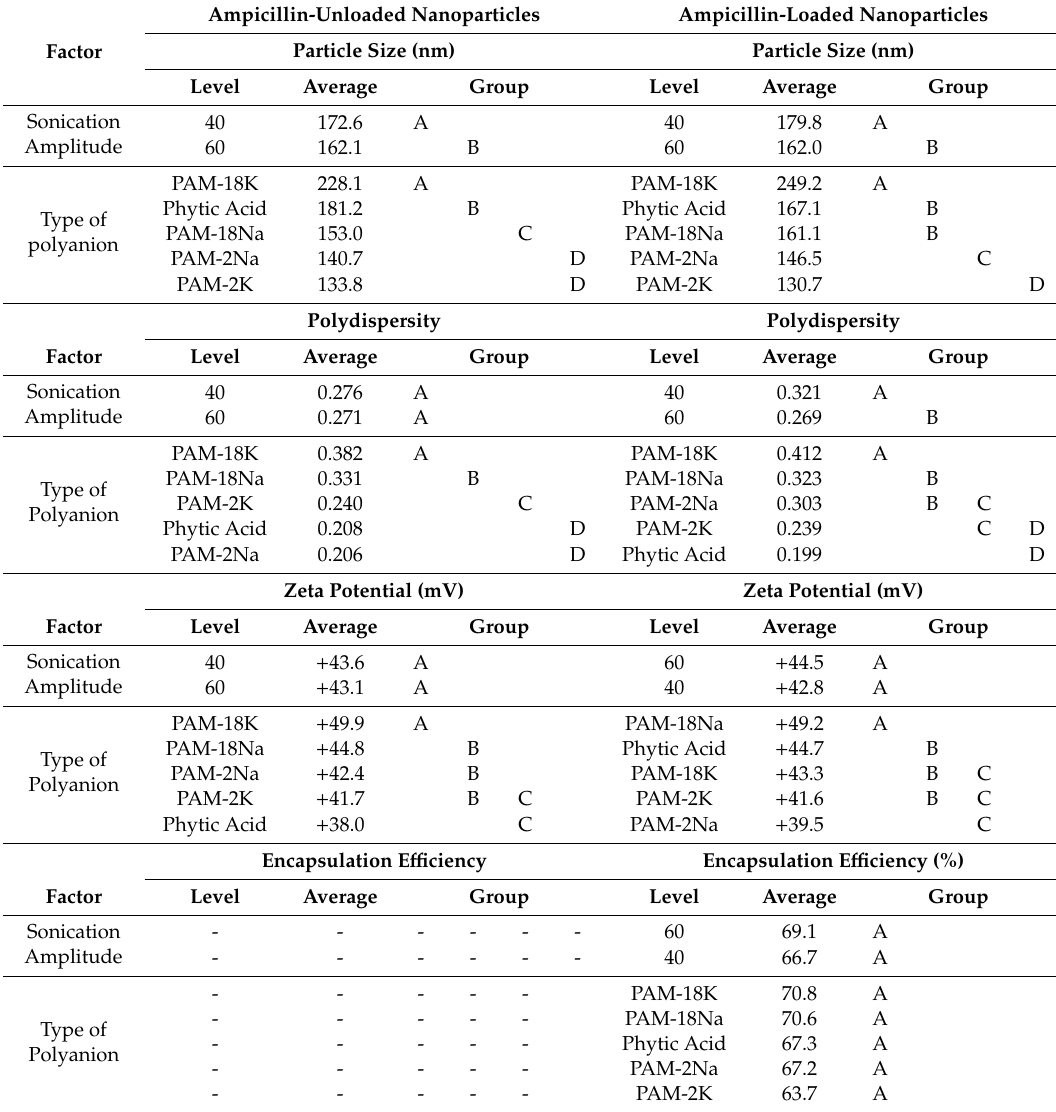
Table 1. Results from the post-hoc Tukey test assessing the e ff ect of sonication amplitude and polyanion type on the physicochemical characteristics of chitosan–polyanion nanoparticles (i.e., particle size, PDI, zeta potential and encapsulation e ffi